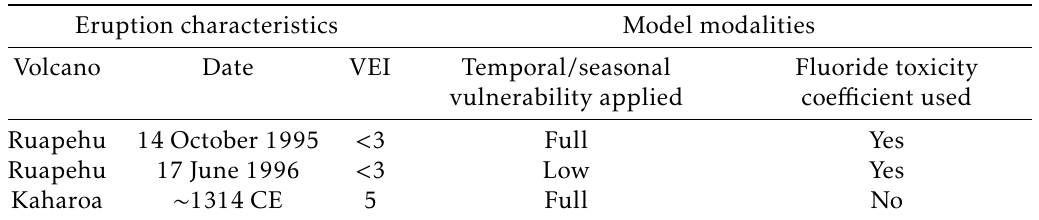
Table 3: Deterministic scenarios used to apply agricultural fragility functions [Johnston et al. 2000; Sahetapy-Engel et al.